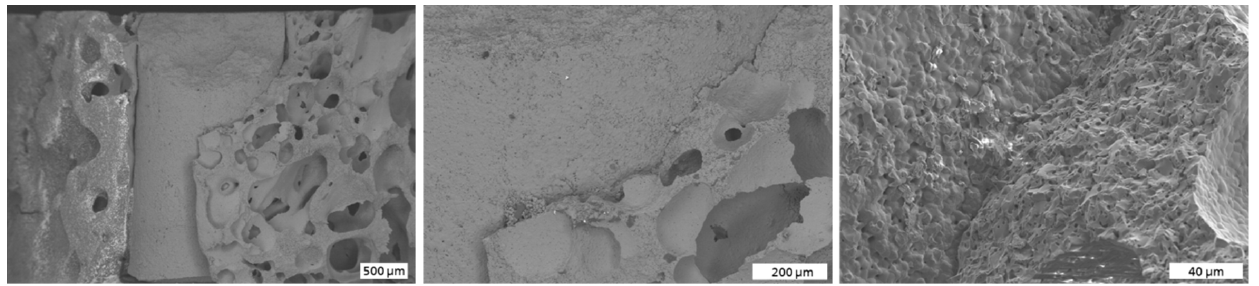
Figure 6. FESEM image: measured distance in the gap interface of VPP column and Freeze Foam.